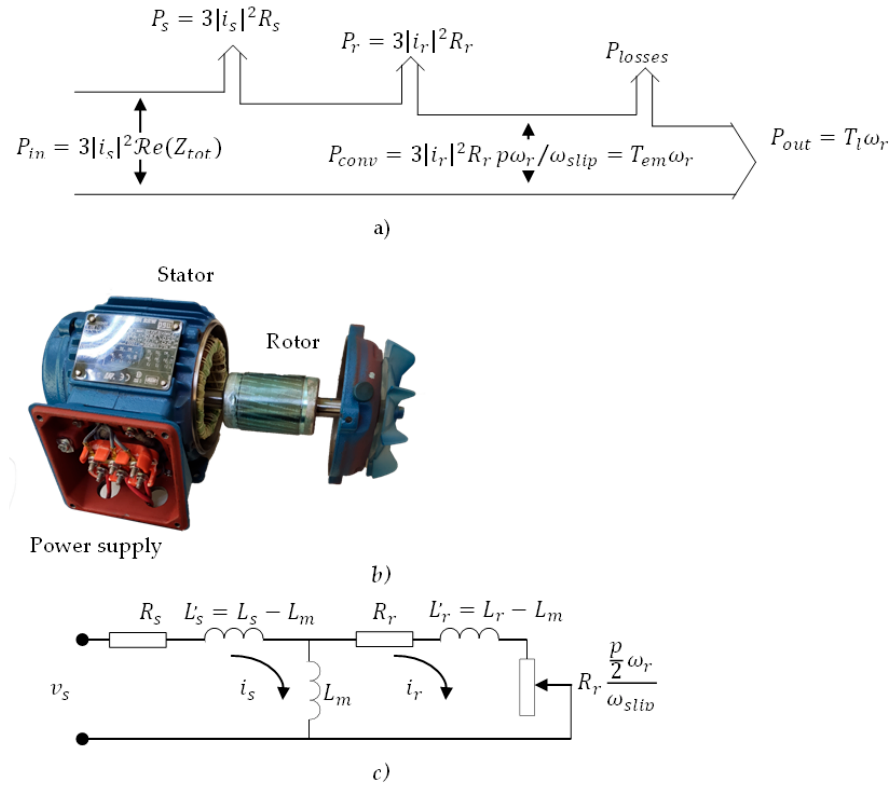
Figure A1. Steady-state IM model per phase. ( a ) Power flow diagram, ( b ) components and parts, ( c ) equivalent circuit.